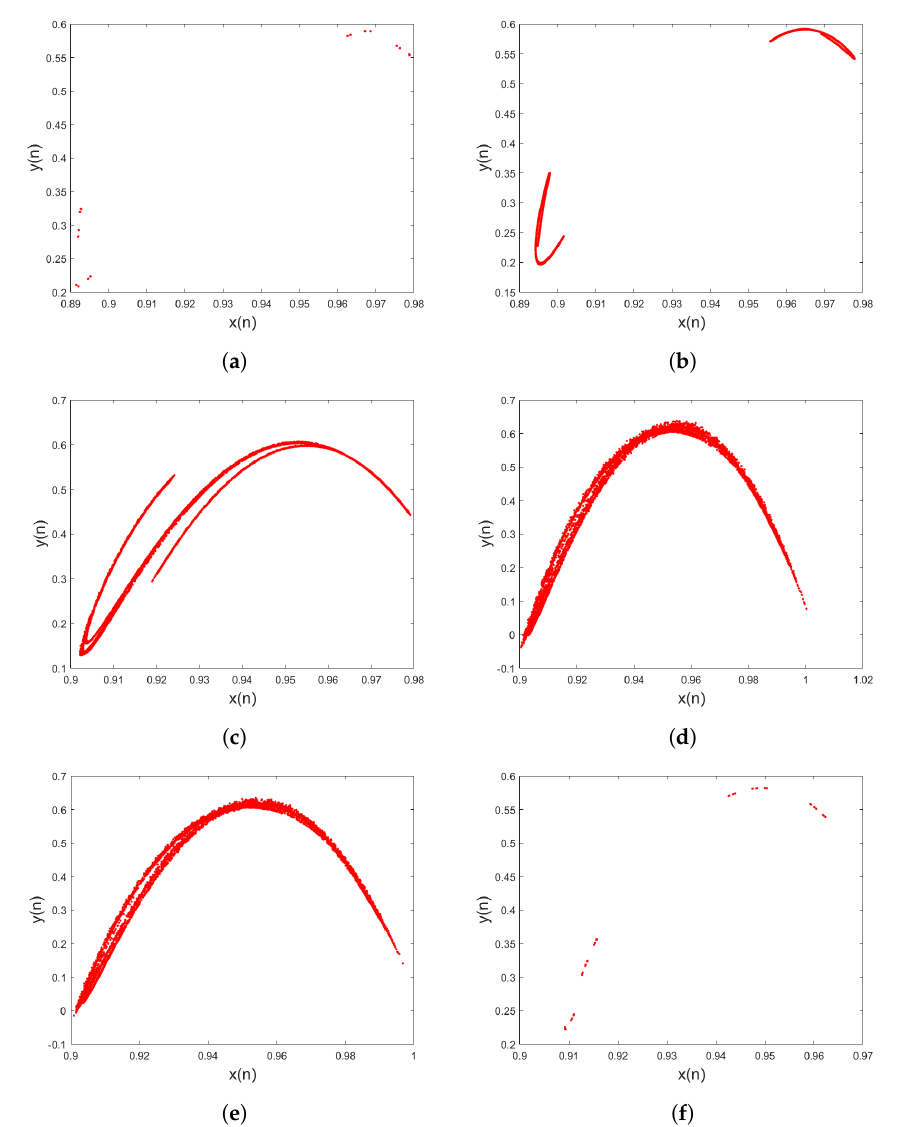
Figure 7. Phase portraits of (11) for a = 2.5, b = 5, c = 5.5, δ = 1.05 and with different fractional or- ders ( a ) ( γ 1 , γ 2 ) = ( 0.65,0.8 ) ( b ) ( γ 1 , γ 2 ) = ( 0.7,0.8 ) ( c ) ( γ 1 , γ 2 ) = ( 0.9,0.8 ) ( d ) ( γ 1 , γ 2 ) = ( 1,0.55 ) ( e ) ( γ 1 , γ 2 ) = ( 1,0.6 ) ( f ) ( γ 1 , γ 2 ) = ( 1,0.931 )